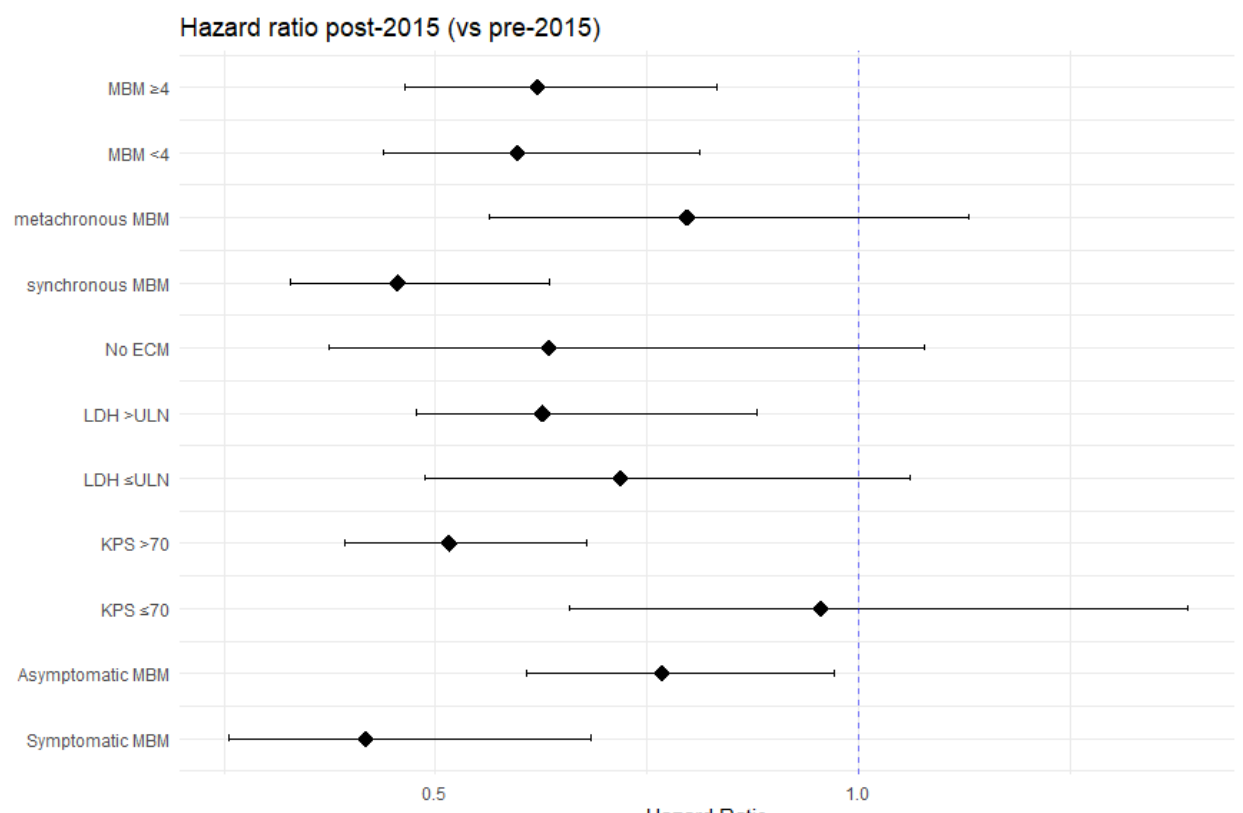
Figure 1. ( a ) Kaplan – Meier curve of overall survival in the total cohort ( n = 430) of patients with melanoma brain metastasis (MBM). ( b ) Kaplan – Meier curves of overall survival of patients diag- nosed with MBM pre-2015 ( n = 152) and post-2015 ( n = 278).